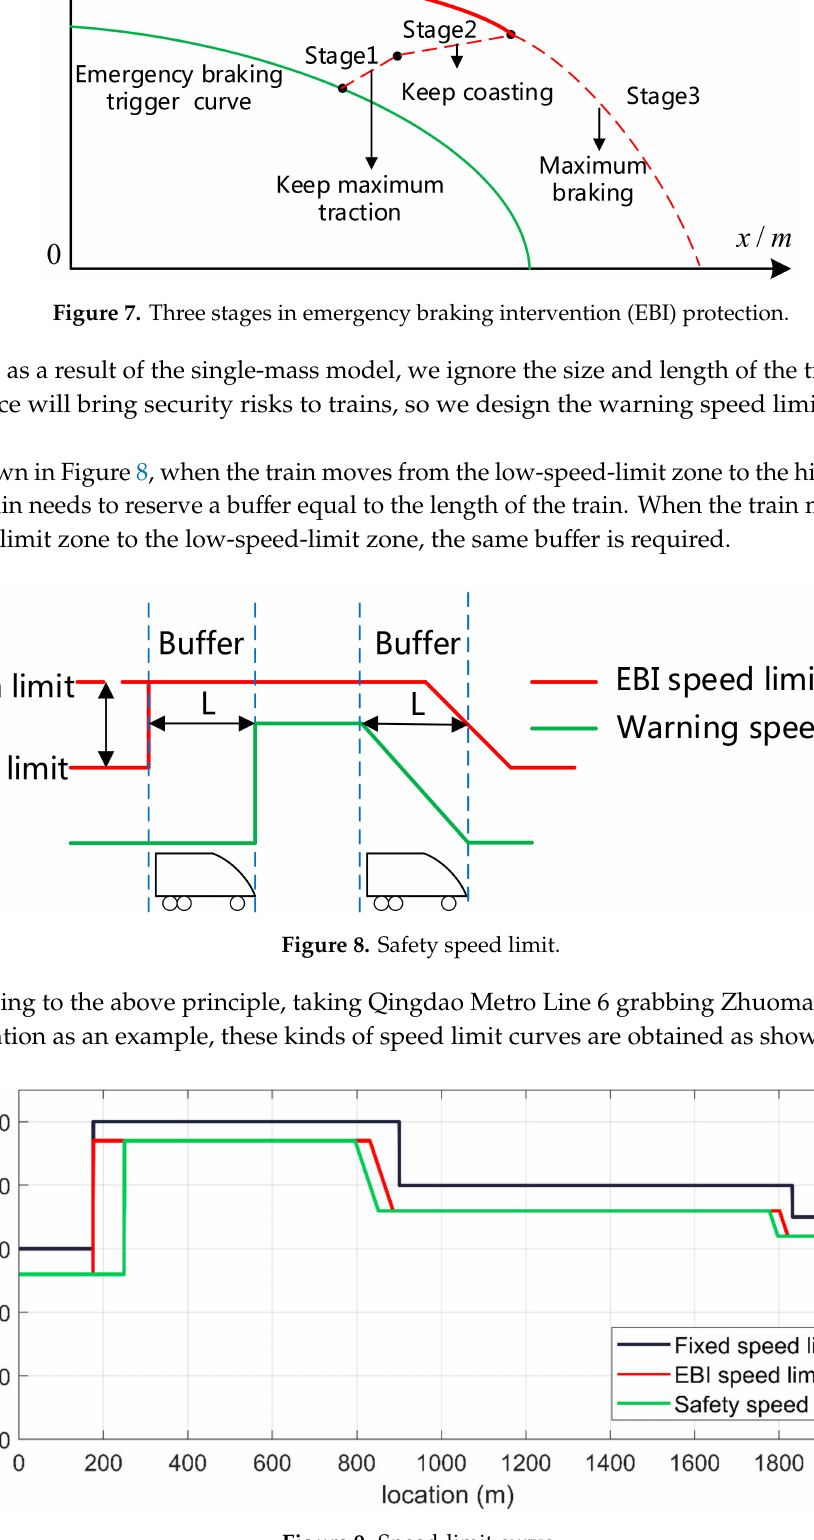
Figure 9. Speed-limit